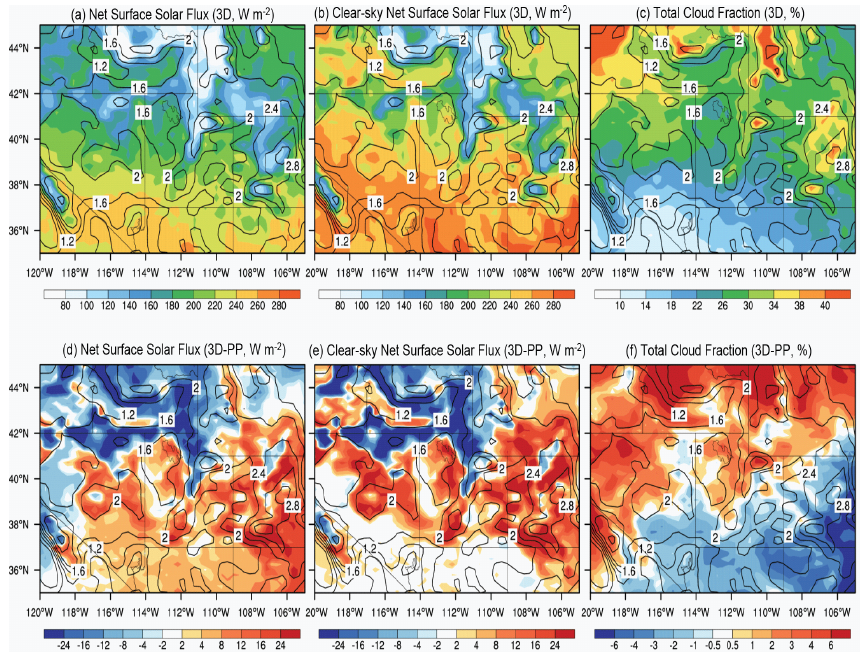
Figure 2. The April mean (a) net surface solar flux (Wm − 2 ) , (b) clear-sky net surface solar flux (Wm − 2 ) , and (c) total cloud fraction simulated for the 3-D case, and differences (3-D–PP) in (d) net surface solar flux, (e) clear-sky net surface solar flux, and (f) total cloud